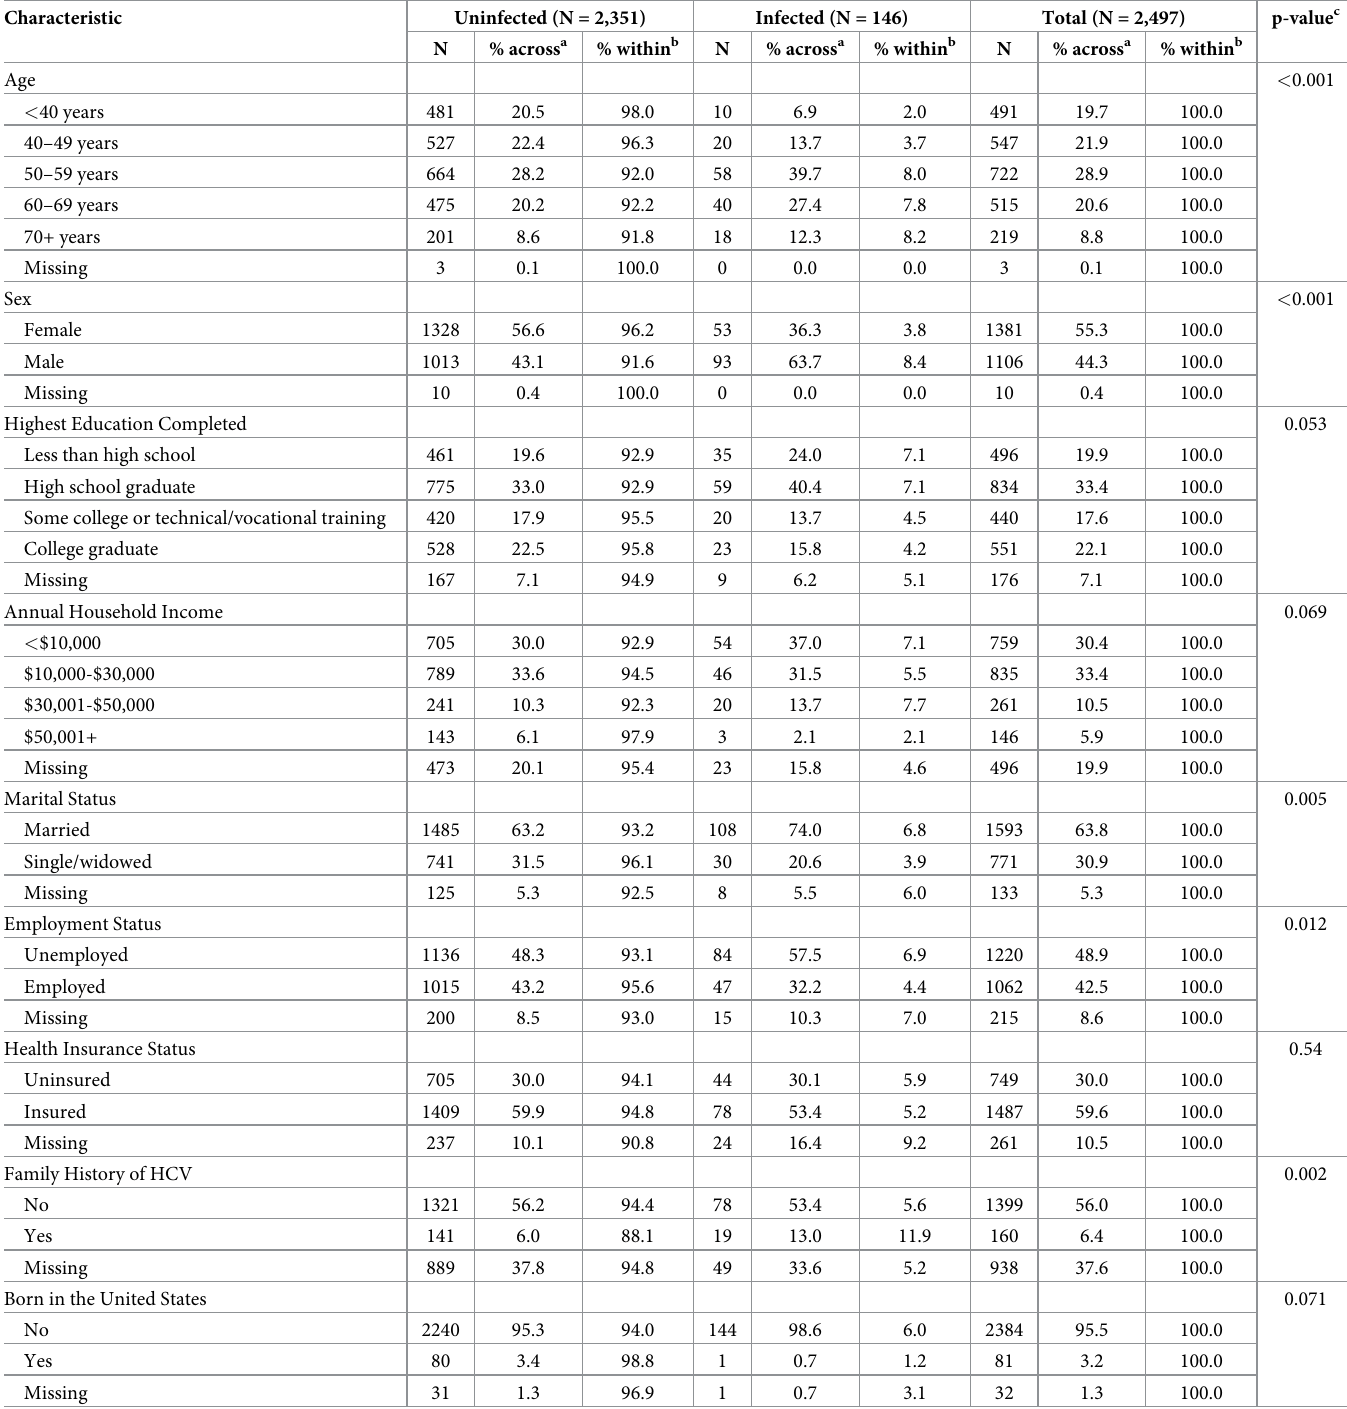
Table 1. Characteristics of study participants by HCV infection